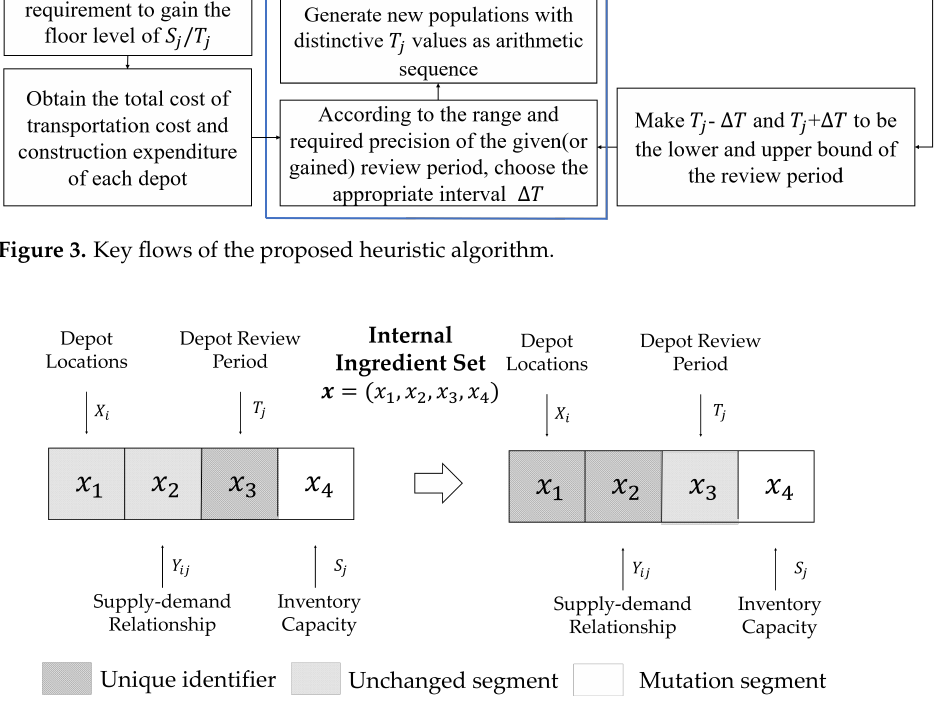
Figure 4. Internal structure of the bilevel population